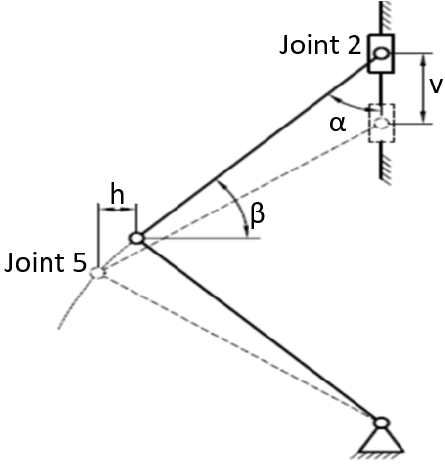
Figure 6. Representation of the displacement v and h.